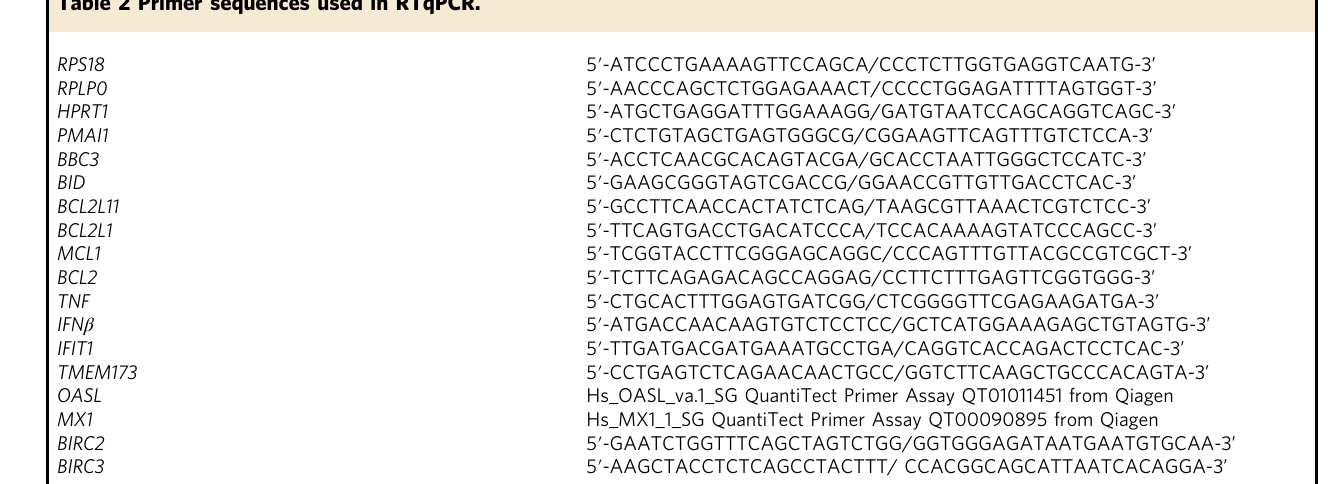
Table 2 Primer sequences used in